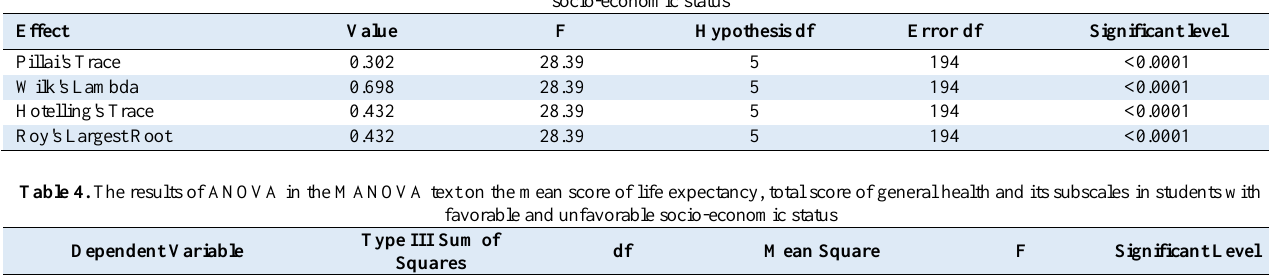
socio-economic status